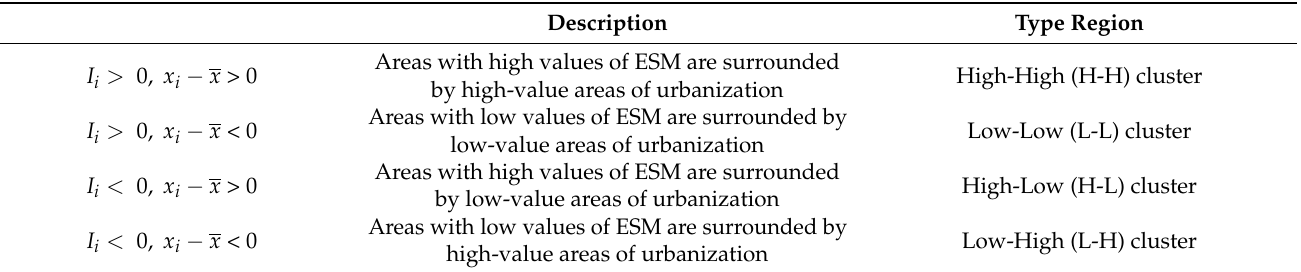
Table 2. Details of the local indicator of spatial association (LISA) map between ecosystem service multifunctionality (ESM) and urbanization. Description Type